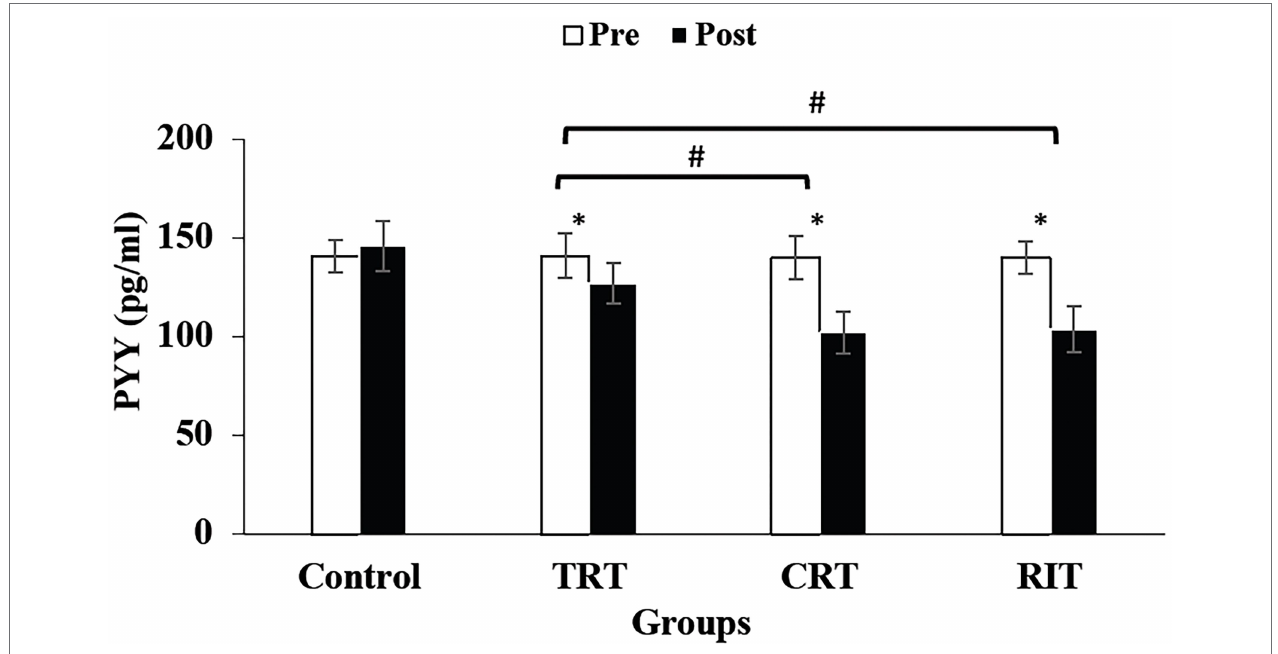
FIGURE 2 | Pre- and post-training values (mean ± SD) for Peptide YY in TRT, CRT, IRT, and groups. * Indicates significant differences from the control group ( p < 0.05). # Indicated significant differences between training protocols ( p <